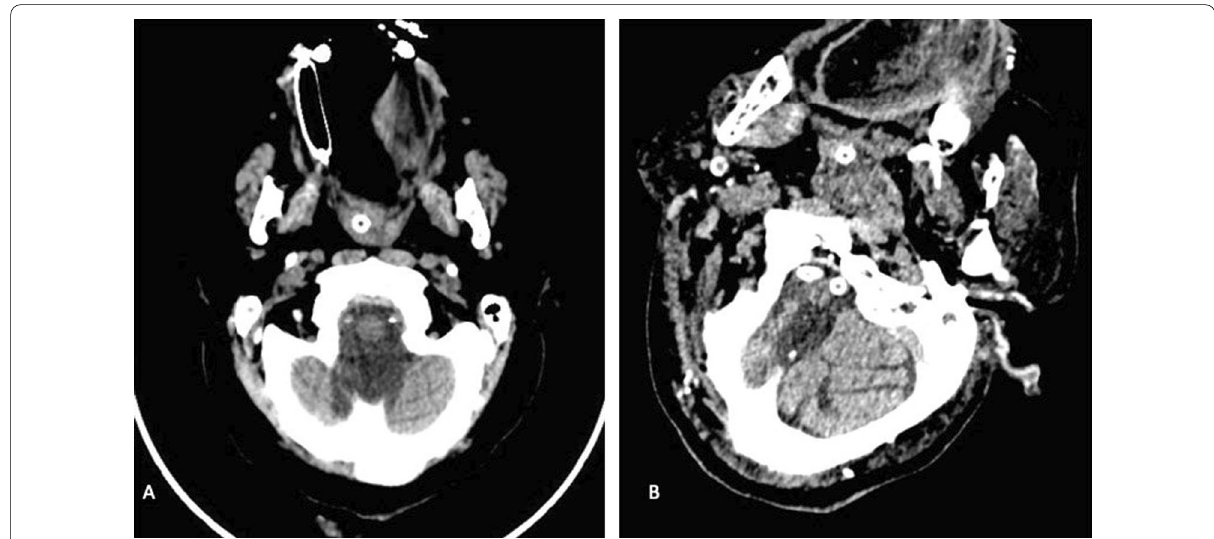
Fig. 1 Two different patients showing posterior circulation calcification. A A 46-year-old male patient with a history of posterior stroke, non-enhanced CT brain of posterior fossa demonstrating dense calcifying in the left vertebral artery. B A 55-year-old male patient with a history of stroke, non-enhanced CT brain of posterior fossa showing a dense calcification in bilateral vertebral